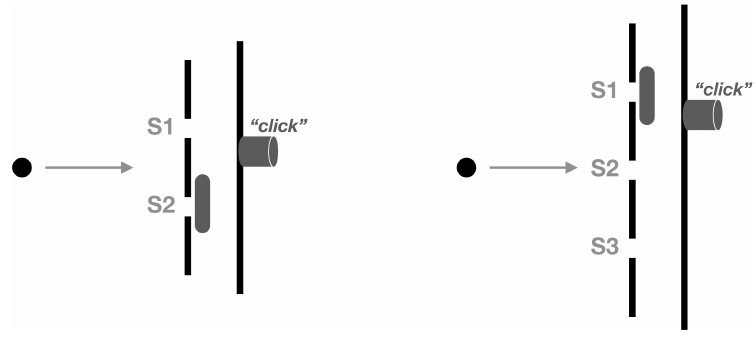
Figure 4: Interference at an M -slit arrangement, where M = 2 (left, the double-slit) resp. M = 3 (right, the triple-slit). For a fixed initial state preparation, we can ask for the probability of the detector click, depending on which (if any) slits are blocked. On the left, slit S 2 is blocked, and the resulting click probability is denoted P 1 . On the right, slit S 1 is blocked, and the resulting click probability is denoted P 23 . For the double slit, P 12 = P 1 + P 2 is an expression of interference of & order n = 2. For the triple-slit, QT predicts Eq. (2). A violation of this would be a novel physical